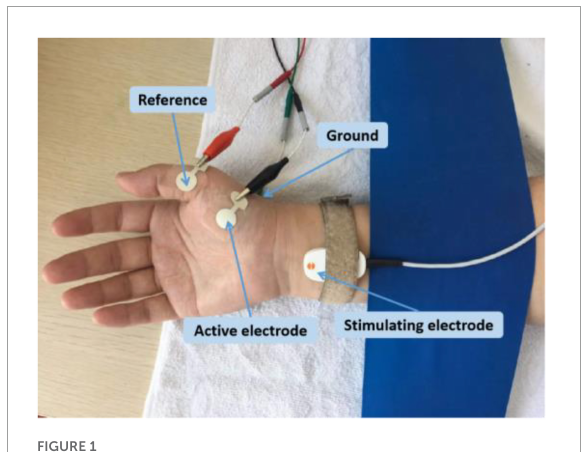
FIGURE1 Electrode placement for CMAP scan recording of the